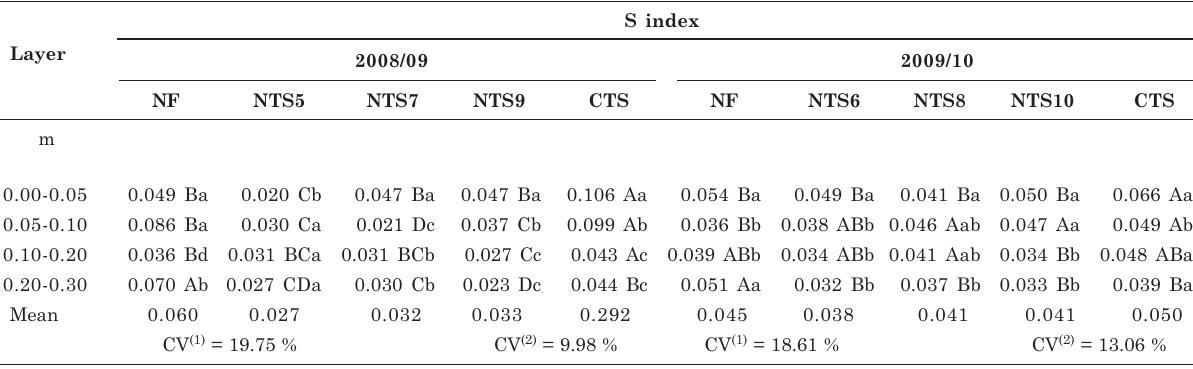
(1) Coefficient of variation of treatments (plots) and (2) coefficient of variation for layers (split-plots). 2008/09 growing season: NF: native forest; NTS5: five-year no-tillage system; NTS7: seven-year no-tillage system; NTS9: nine-year no-tillage system; and CTS: conventional tillage system. 2009/10 growing season: NF: native forest; NTS6: six-year no-tillage system; NTS8: eight-year no-tillage system; NTS10: ten-year no-tillage system; and CTS: conventional tillage system in a Red Oxisol. Mean values followed by the same letter do not differ from each other by the Tukey test (p<0.05). Upper-case letters indicate the comparison of soil properties in the same layer, and lower-case letters compare mean values of layers of the same soil